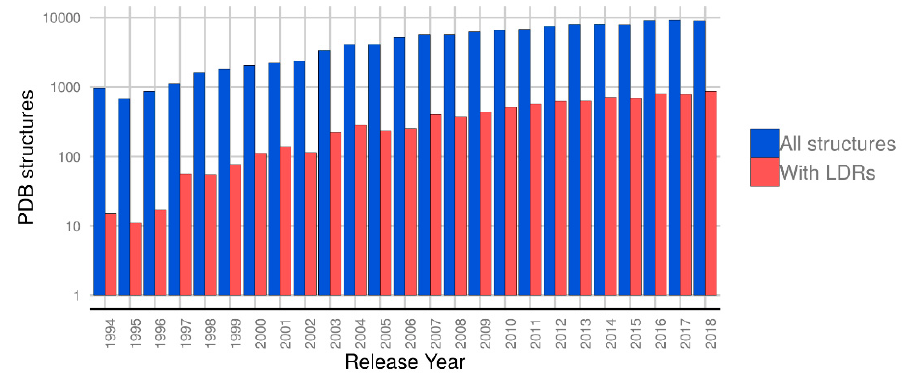
Figure 1. Growth of proteins with Long Disorder Regions (LDRs) in the PDB. In blue, the amount of structures deposited by year in the PDB. In red, the amount of deposited structures with at least one LDR. The y-axis is expressed in logarithmic scale.